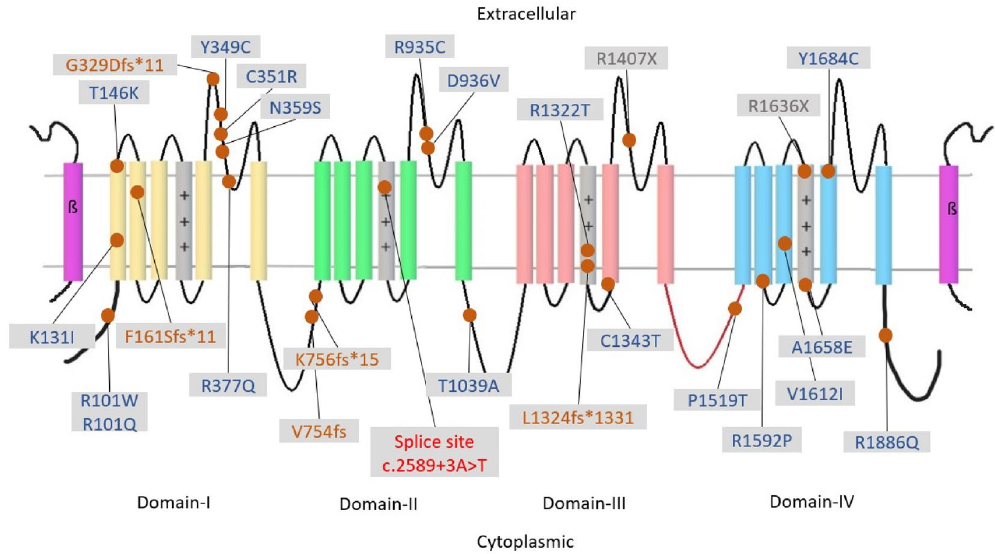
Figure 1. Schematic representation of sodium channel type-1 (Na v 1.1) mutations in our study. The SCN1A alpha unit has four domains (I–IV). Each domain includes six transmembrane segments (S1–S6). Inactivation gate (red line); voltage sensor (gray column). Other two deletion mutations are not marked: (1) 2q24.3q31.1 deletion; (2) microdeletion 2q chromosome. Missense (blue); frameshift (brown); nonsense (gray); splice site